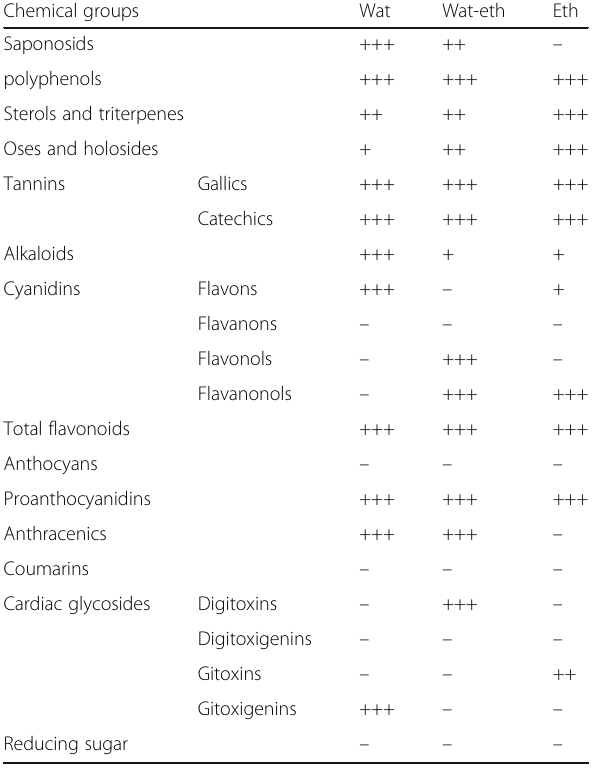
Table 1 Results of the preliminary phytochemical screening Chemical groups